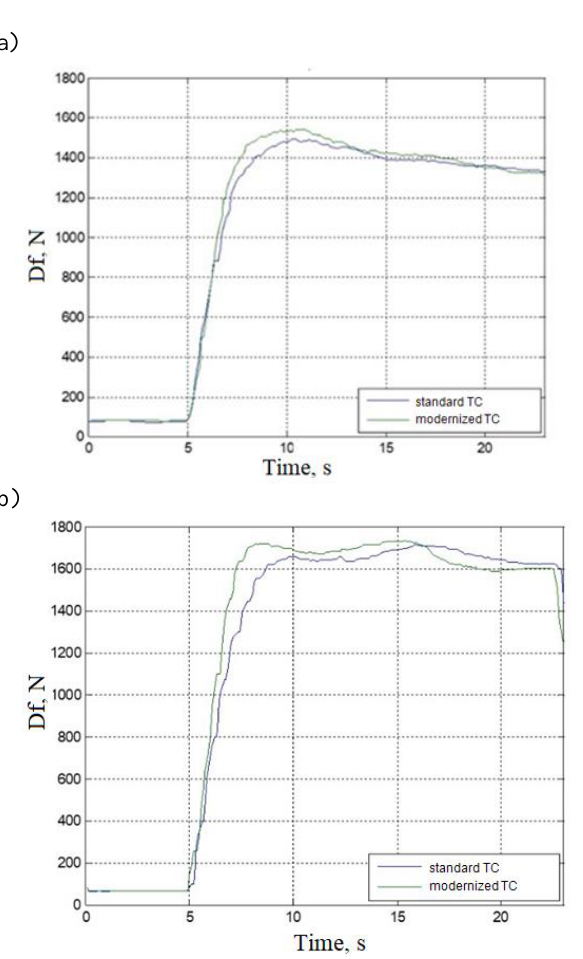
Fig. 6. Comparison of the powertrain output in the car acceleration elas- ticity test for a car with step-gear transmission on a dynamometer for Table 3. Increase in the engine power for a constant position of the accel- erator pedal Accelerator position,